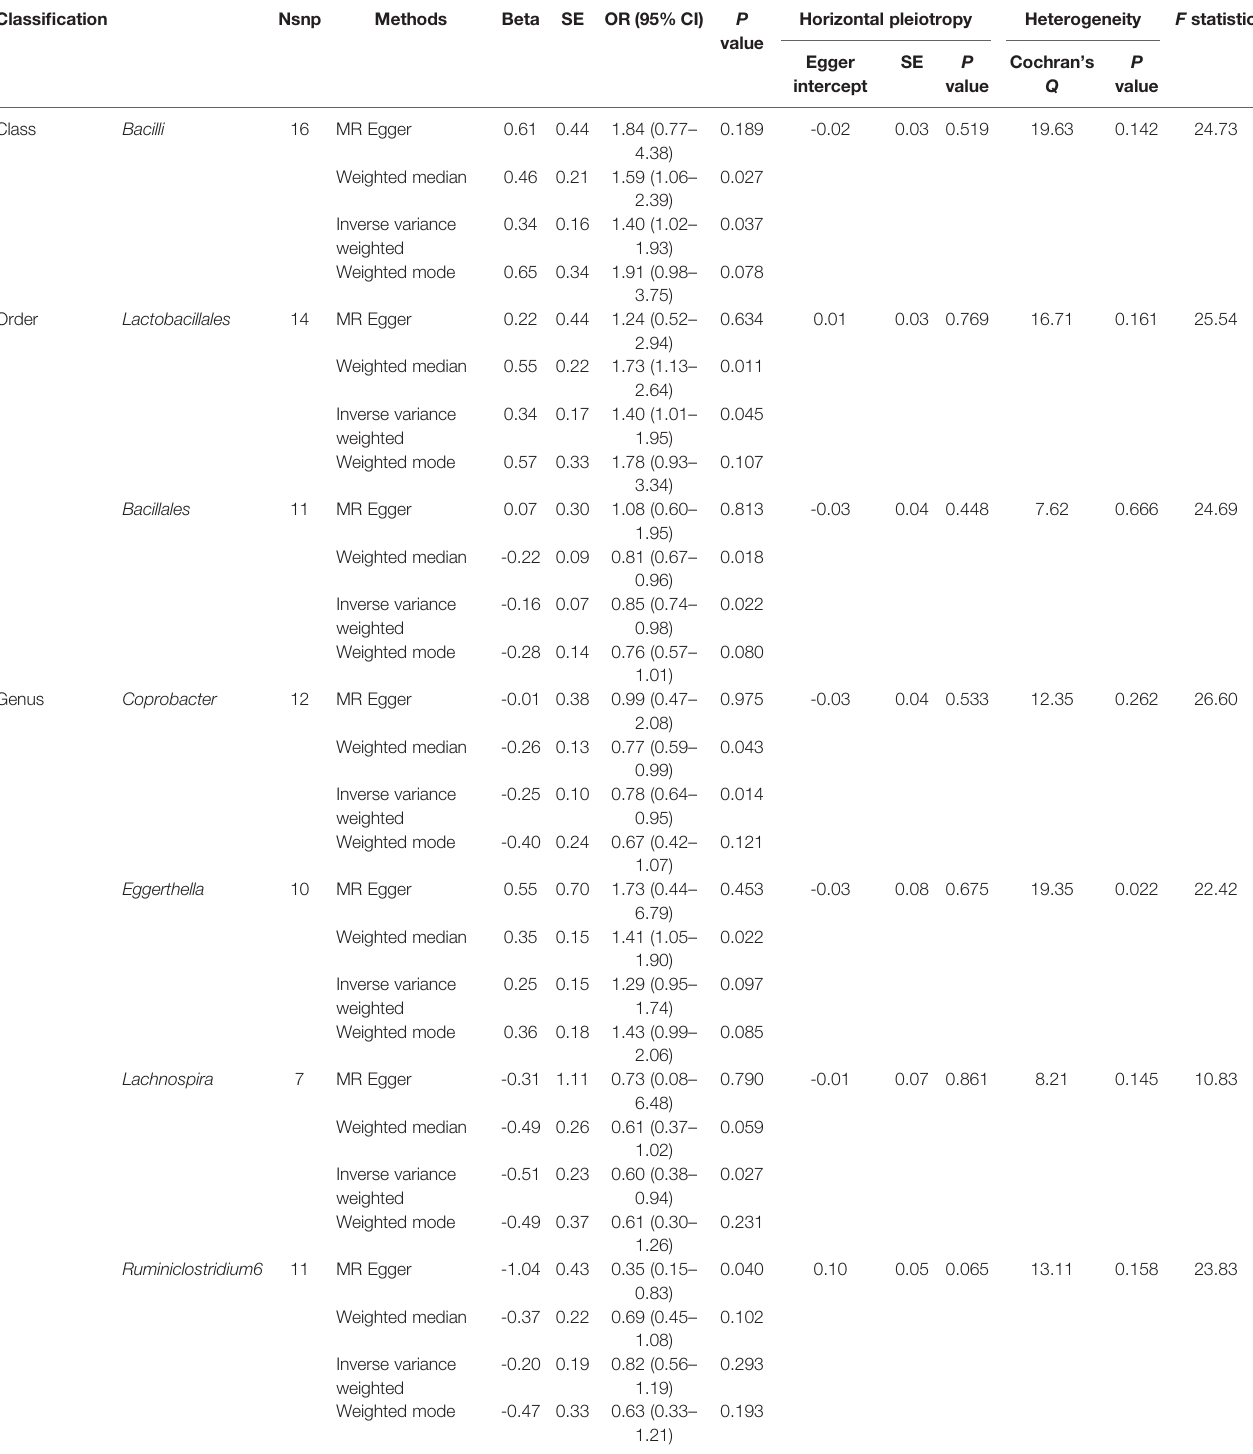
TABLE 1 | MR results of causal links between gut microbiome and SLE risk ( P < 1 × 10 -5